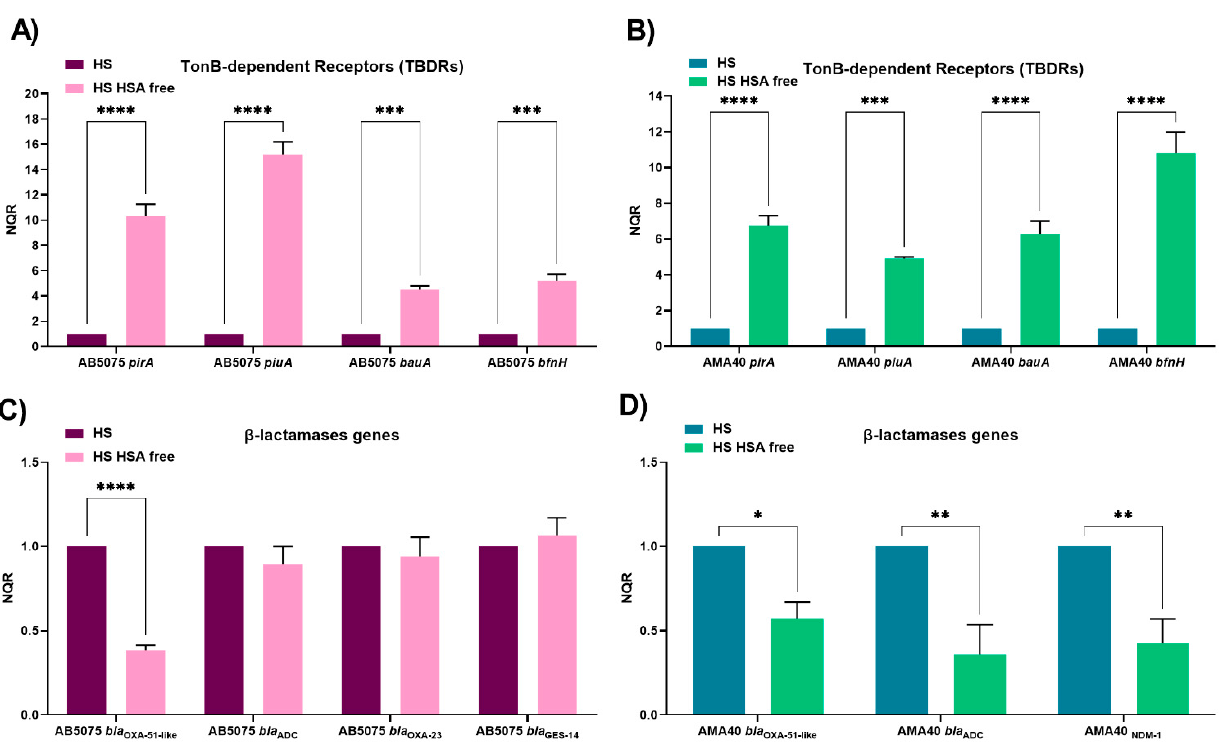
Figure 1. Expression analysis of iron uptake genes and genes coding for β -lactamases in the AB5075 ( A , C ) and AMA40 ( B , D ) strains. The qRT-PCR of TonB-dependent receptors ( pirA, piuA, bauA, and bfnH ) and bla genes ( bla OXA-51-like , bla ADC , bla OXA-23 , bla NDM-1 , and bla GES-11 ) expressed in the presence of human serum (HS) or HSA-free HS. The data shown are the mean ± SD of normalized relative quantities (NRQ) obtained from transcript levels calculated using the qBASE method. This method is a modification of the classic ∆∆ Ct method used to take multiple reference genes (in this work, rpoB and recA ) and gene-specific amplification efficiencies into account. At least three independent samples were used, and four technical replicates were performed from each sample. The HS condition was used as reference. Statistical significance ( p < 0.05) was determined by two-way ANOVA followed by Tukey’s multiple comparison test, one asterisk: p < 0.05; two asterisks: p < 0.01; three asterisks: p < 0.001; and four asterisks: p < 0.0001.